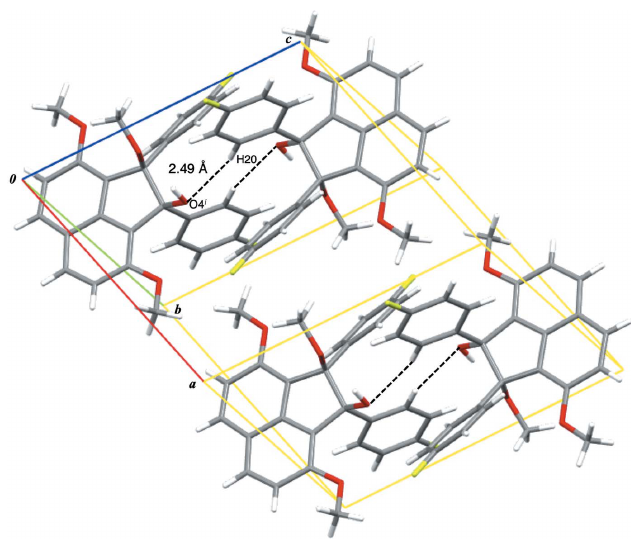
Figure 3 A view of the crystal packing of the title compound, showing the centrosymmetric dimers. The non-classical O—H (cid:2)(cid:2)(cid:2) O hydrogen bonds are shown as dashed lines [symmetry code: (i) (cid:5) x , (cid:5) y + 1, (cid:5) z + 1]. between hydroxy group O4—H4 and oxygen atom O3 of the methoxy group at the 1- and the 2-positions of the acenaph- thene ring system (see Table 1). An intramolecular C—H (cid:2) (cid:2) (cid:2) (cid:2) interaction between hydrogen atom H24 of one of the 4-fluorophenyl groups and the acenaphthene ring system is also observed (C24—H24 (cid:2) (cid:2) (cid:2) Cg 9 = 2.90 A˚ ; Cg 9 is the centroid of the acenaphthene ring; see also Table 1). The possibility of